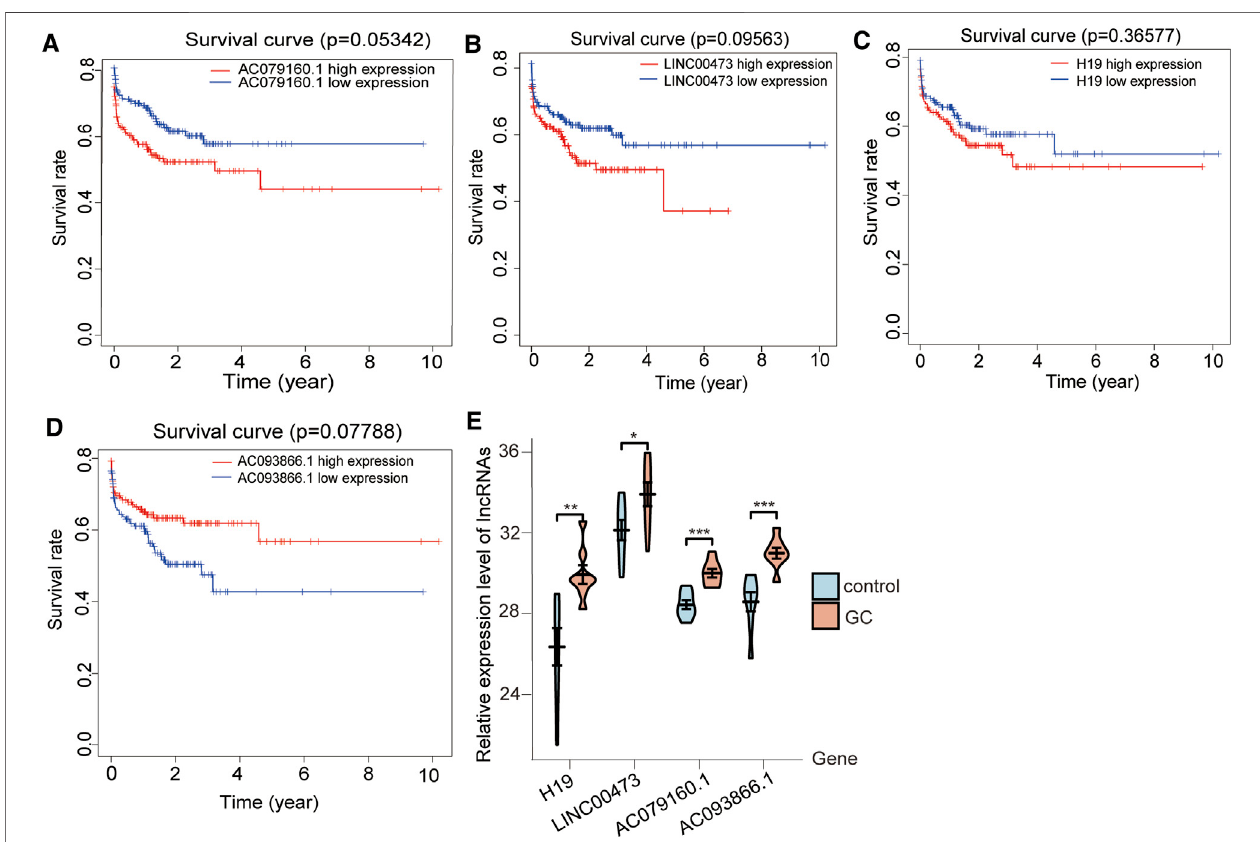
FIGURE6| ExpressionofthefourlncRNAscorrelateswithprognosisinGC.ThelevelsofthelncRNAs (A) H19, (B) INC00473,and (C) AC079160.1werepositively correlatedwithpatientsurvival,whereas (D) AC093866.1showedanegativecorrelationwithpatientsurvival.Kaplan – MeiersurvivalcurvesforGCpatientsweregrouped into high and low risk based on the lncRNA expression signature. The x -axis represents overall survival time in years, while the survival rate is shown on the y -axis. p -values were determined by the log-rank test. (E) lncRNA expression evaluated by qRT-PCR in GC and adjoining noncancerous tissues. Data are presented as mean ± standard errors of the mean (* p < 0.05, ** p < 0.01, *** p < 0.001).